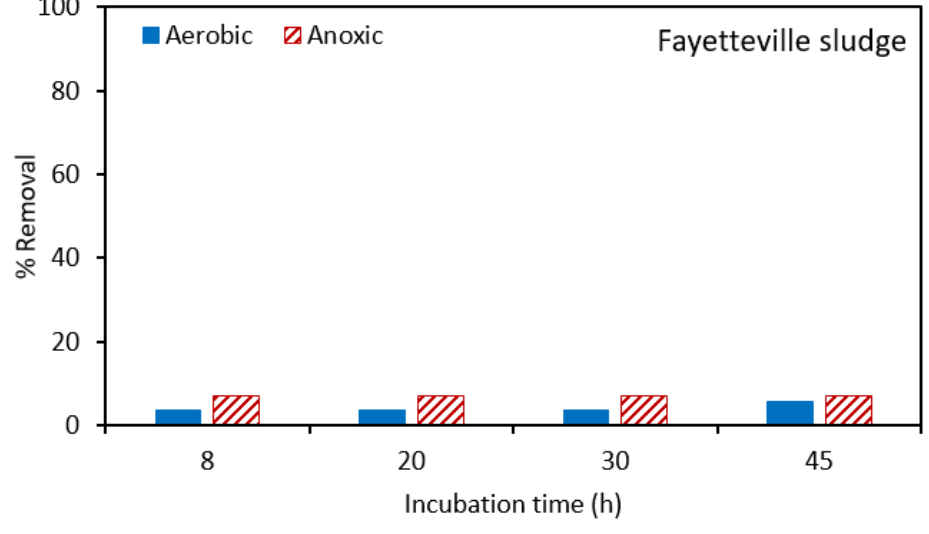
Figure 6. Parentage of atrazine removal using Norman sludge. The initial atrazine concentration was 1 ppm. The total suspended solids (TSS) for aerobic and anoxic tanks was 7244 and 5435 ± 600 mg/L, respectively.